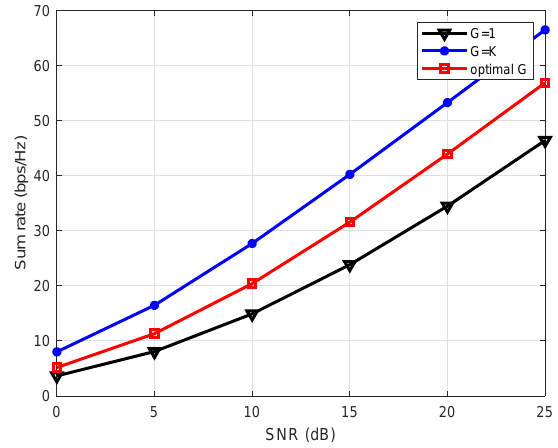
Figure 9. Sum-rate Vs SNR with different number of groups, K = 8.